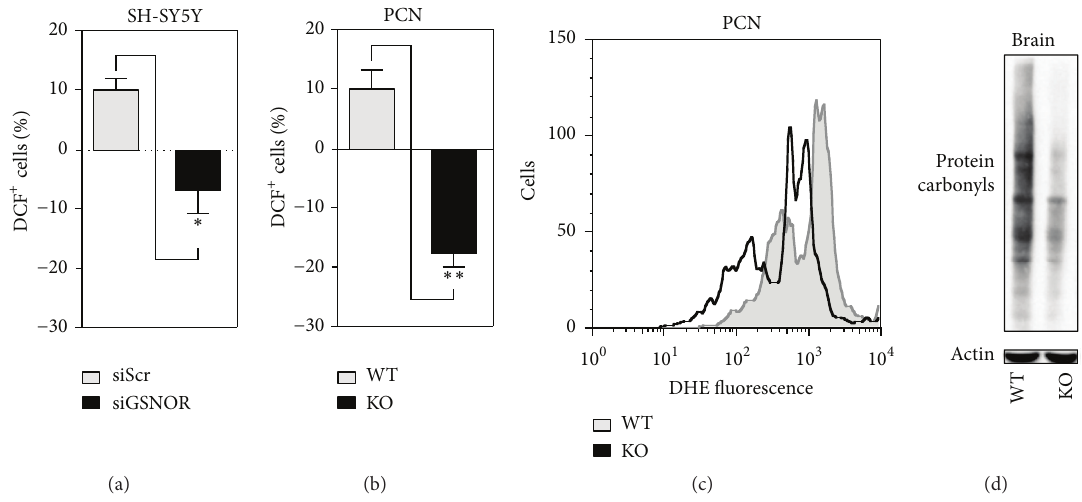
Figure 3: ROS production and protein carbonylation in GSNOR-downregulating systems. (a) Cytofluorimetric analyses of H 2 O 2 in siScr and siGSNOR SH-SY5Y cells upon 2 󸀠 ,7 󸀠 -dihydrodichlorofluorescein (DCF) staining. (b) Cytofluorimetric analyses of H 2 O 2 and O 2∙− in GSNOR-KO and WT PCN upon 2 󸀠 ,7 󸀠 -dihydrodichlorofluorescein (DCF) or (c) dihydroethidine (DHE) staining. (d) Western blot analyses of protein carbonyls from mesencephalon obtained from GSNOR-KO and WT brains. Western blots shown are representative of at least 𝑛 = 3 independent experiments that gave similar results. Actin was selected as loading control. Graphs shown represent the mean of data ± SD of 𝑛 = 3 independent experiments, ∗ 𝑃 < 0.05 and ∗∗ 𝑃 < 0.01